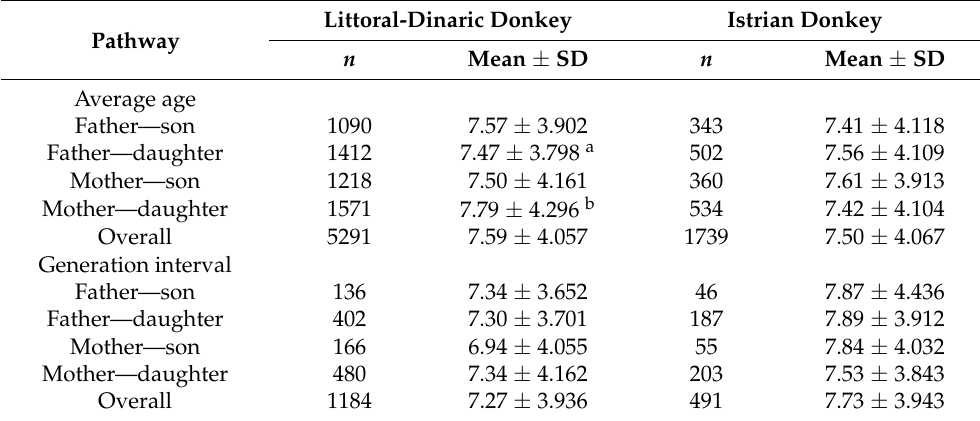
Table 2. Average age of parents at the birth of their offspring and the generation interval (years) for the Littoral-Dinaric donkey and Istrian donkey populations (REF 01). Littoral-Dinaric Donkey Istrian Donkey Pathway n Mean ± SD n Mean ± SD Average age